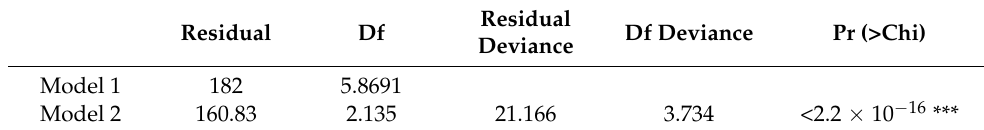
Table 3. Analysis of Deviance summary.